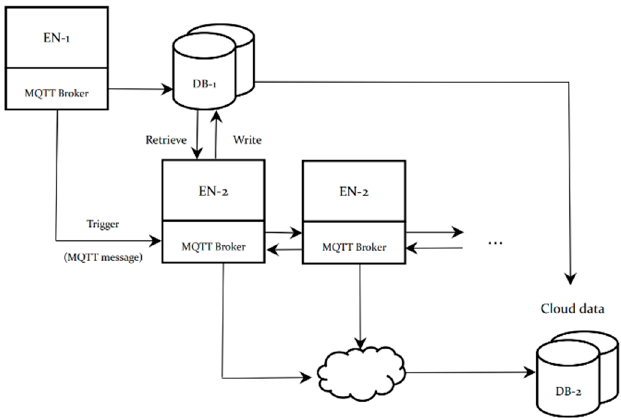
Figure 2. The interaction between grade one and two edge computing nodes in the architecture for WSN.